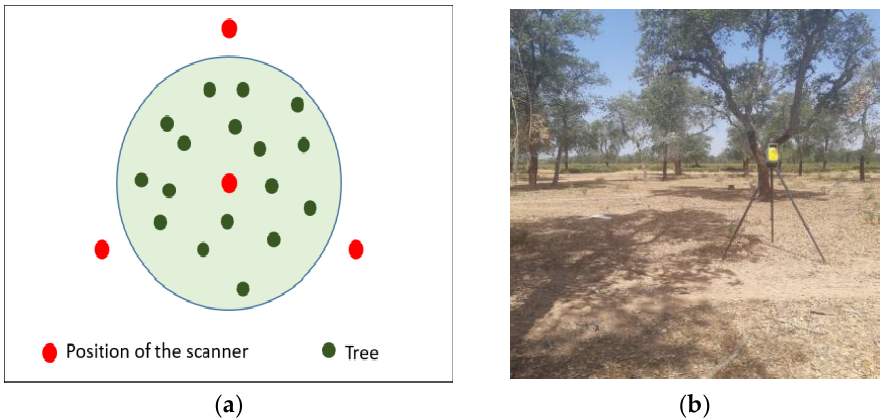
Figure 4. ( a ) Configuration of the Terrestrial laser scanner (TLS) multiscan; ( b ) Terrestrial laser scanner (TLS) operating a scan on the border of the plot.